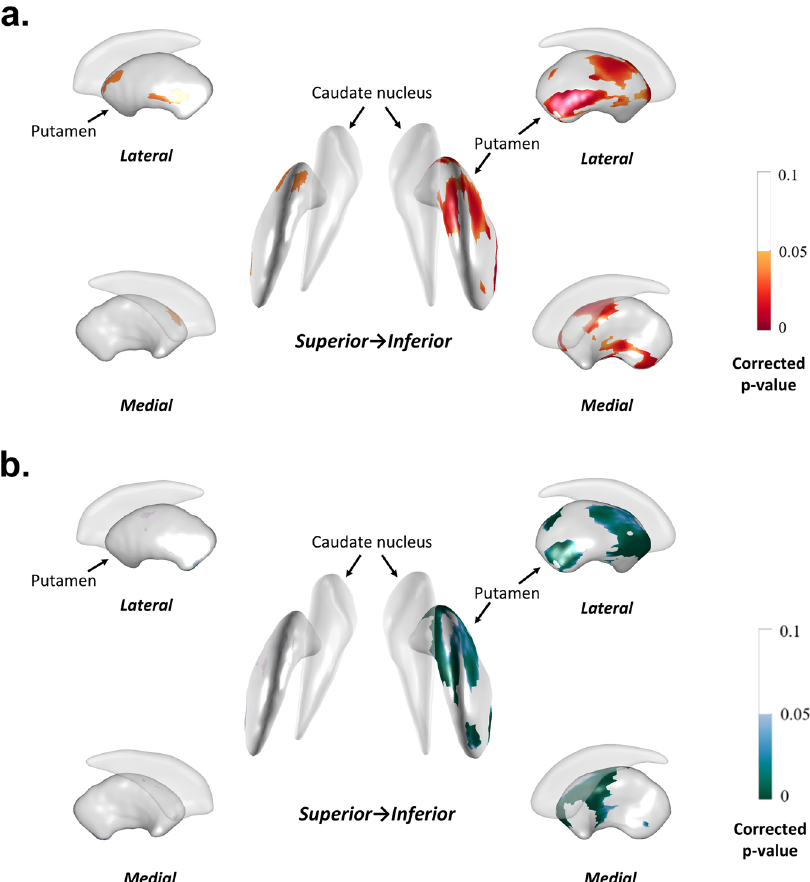
Fig. 3 Local striatal volume and longitudinal LED increase. a Linear mixed model revealed that right anterior and ventro-posterior putamen local volume showed signi fi cant interaction with time for LED increment within 24 months, which means that the larger the local volumes of structures noted above, the slower the rate of LED increment. b However, from 24 months to 48 months, the results were opposite and the large local volume of right anterior and ventro-posterior putamen correlates with a rapid increment of LED. The mapped p values are the results after multiple comparisons correction using the false discovery rate (Fig. 3a). In contrast, patients with a larger volume of the right anterior and ventro-posterior putamen showed an accelerated increment of LED from 24 months to 48 months (Fig. 3b).